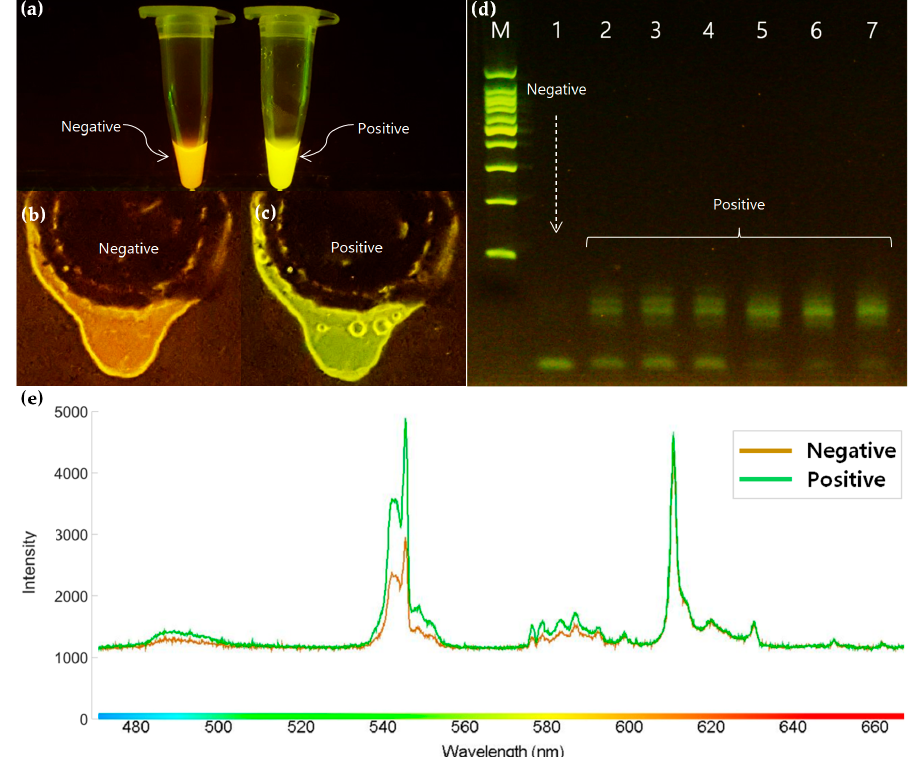
Figure 6. Fluorescence variations under blue LED and an amber filter: ( a ) Tube-based results of negative and positive PCR amplifications, ( b ) the PCR product after negative amplification on a PCR–LOD, ( c ) the PCR product after positive amplification on a PCR–LOD, ( d ) comparison of the electrophoresis results with positive and negative on where (M) represents 100 bp marker, ( e ) spectral properties between the negative and positive amplicons of PCR–LOD.